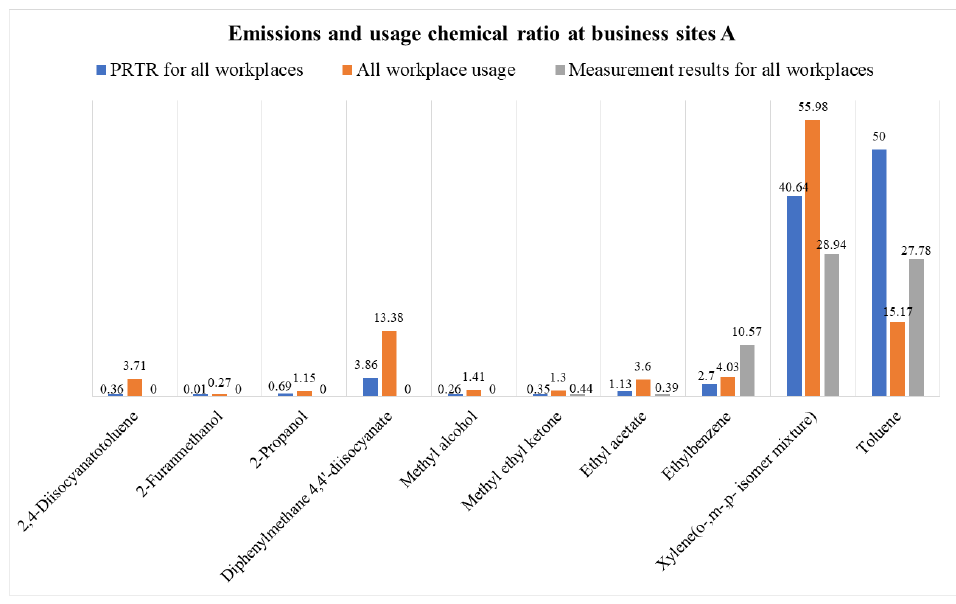
Figure 11. Emissions and usage chemical ratio at business sites A.